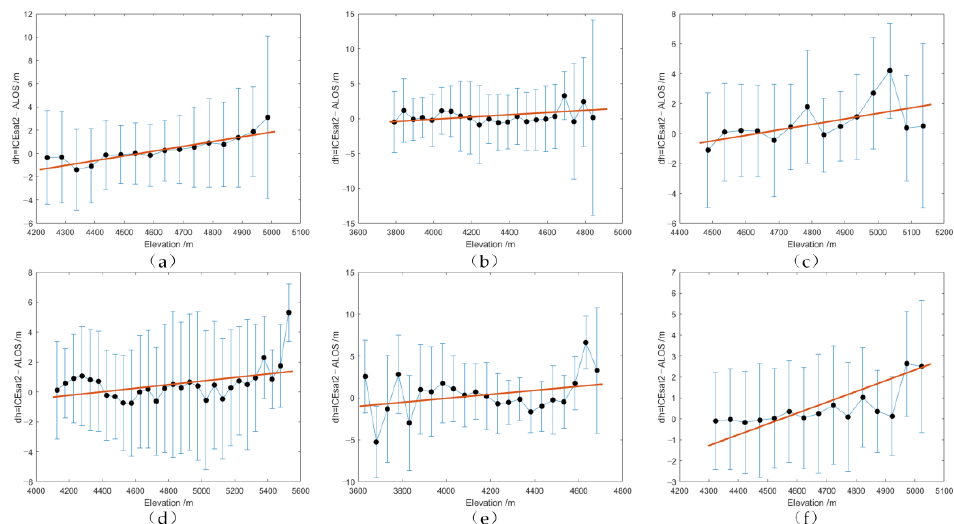
Figure 7. Altitude-dependent related bias correction. ( a – f ) represent Gangnalou Glacier, Laohugou No. 12 Glacier, Dunde Ice Cap, the 93.5°E 39.2°N Glacier, Shiyang River, Bayi, Suzhulian Glacier Group and the 97.2°E 38.7°N Glacier, respectively. The black dots represent the mean value of all elevation differences within every 50 m in the nonglacial elevation interval, the error bar represents the standard deviation of the elevation differences in this bin, and the red line is the related elevation difference trend fitted by the least squares.